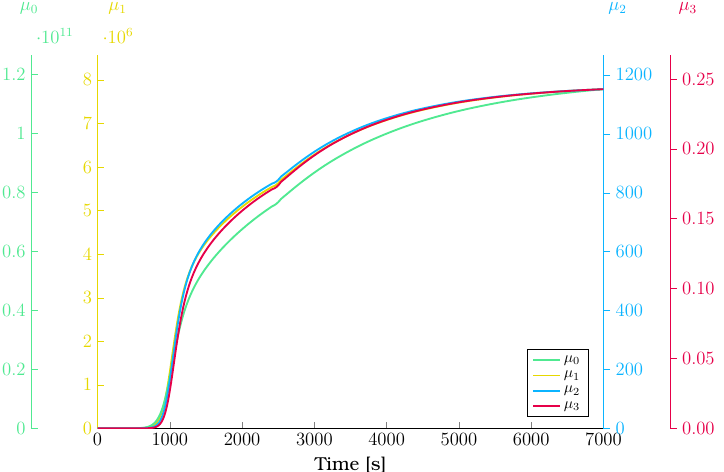
Figure 8. The change in moments ( µ i ) over time in the case of the non-isothermal batch